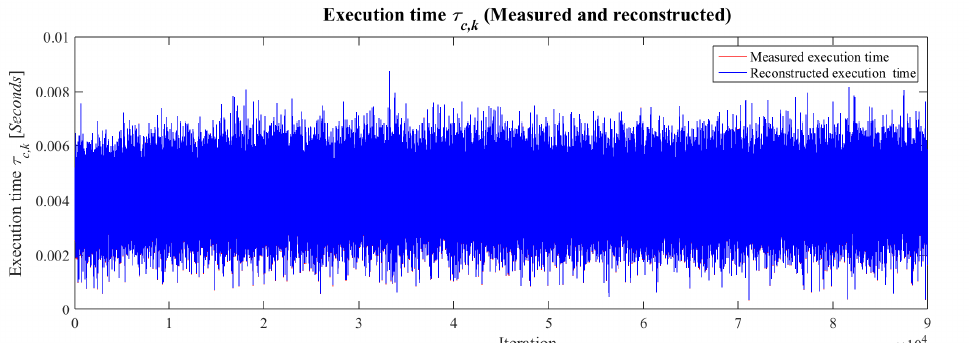
Figure 14. Comparison of execution times τ c , k measured and